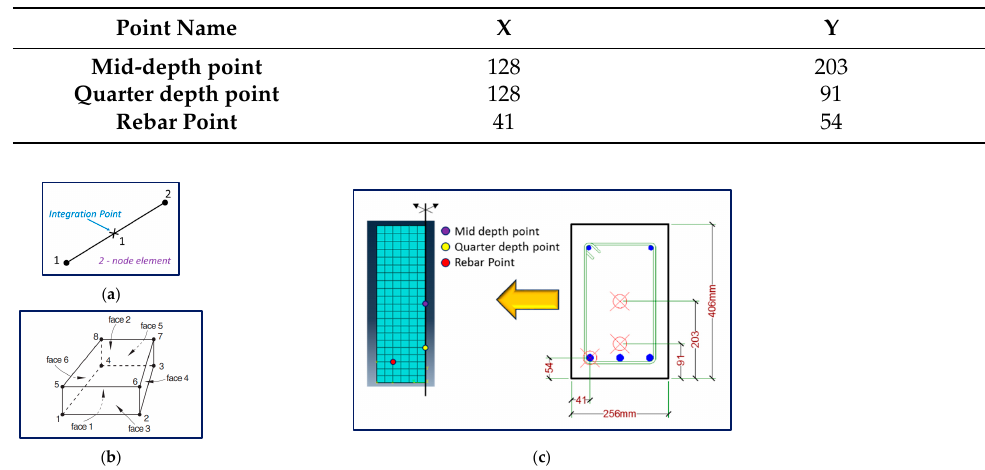
Figure 6. ( a ) T3D2T (2 ‐ node element) Direct Coupled Element [17], ( b ) C3D8T (8 ‐ node element) Di ‐ rect Coupled Element [17], and ( c ) Points used for thermal validation.